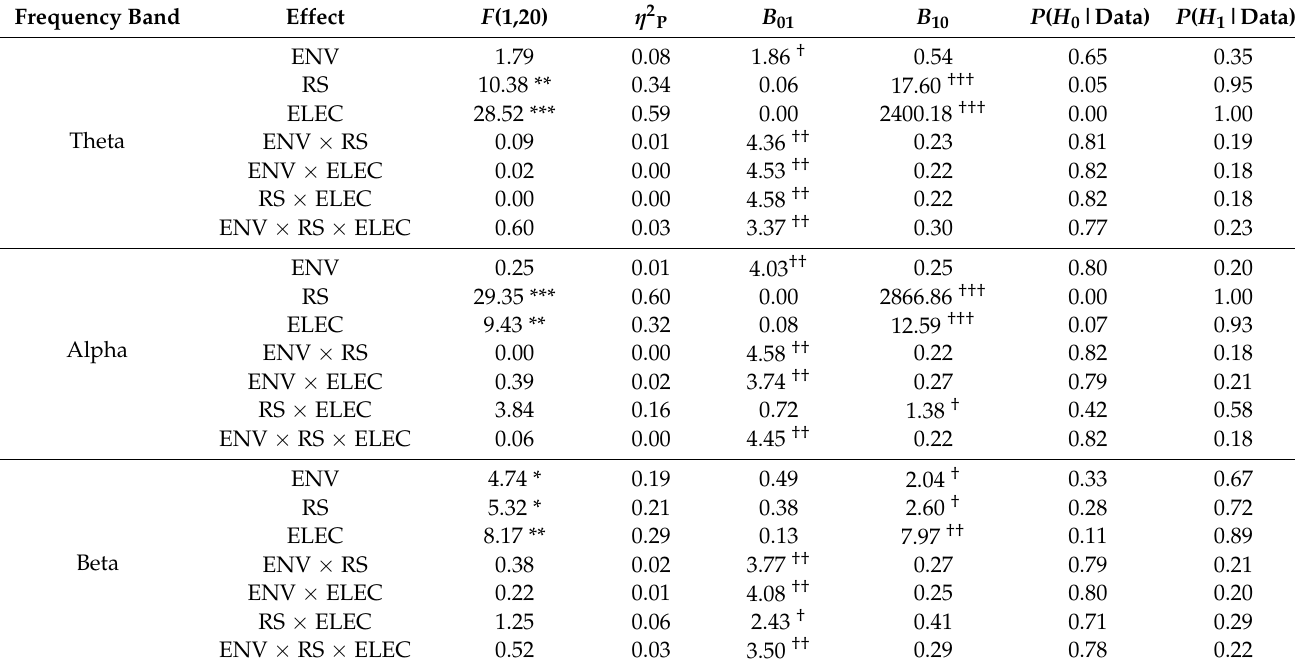
Table 3. Analysis of variance (ANOVA) for Resting Task EEG